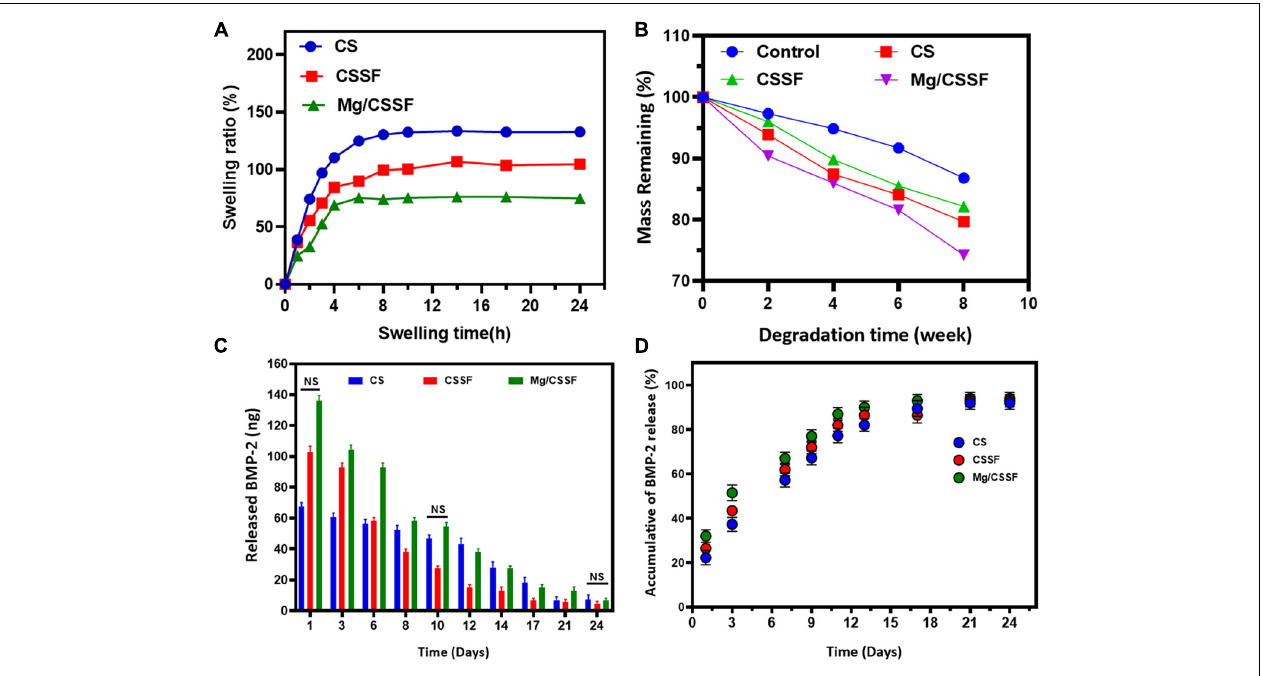
FIGURE 4 | Swelling ratio (A) , biodegradation behaviors (B) , and in vitro recombinant human bone morphogenic protein-2 (rhBMP-2) release profiles (C,D) of fabricated injectable hydrogel groups [CS, chitosan/silk fibroin (CSSF), and Mg/CSSF] for different time durations, as required for experimental